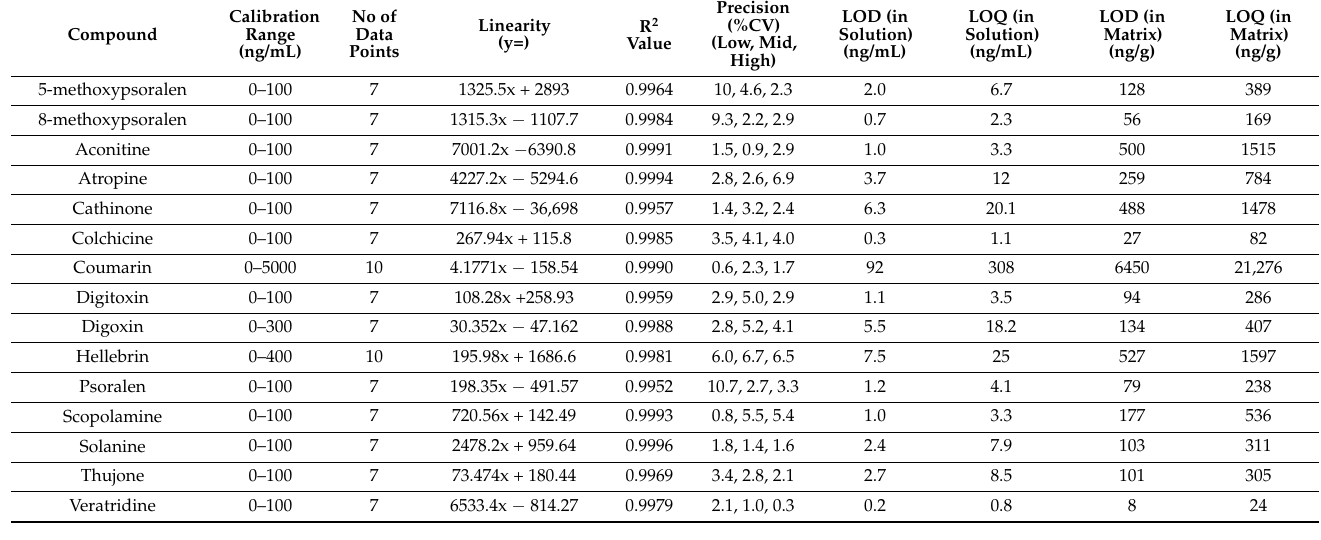
Table 4. Analytical figures of merit for developed method.